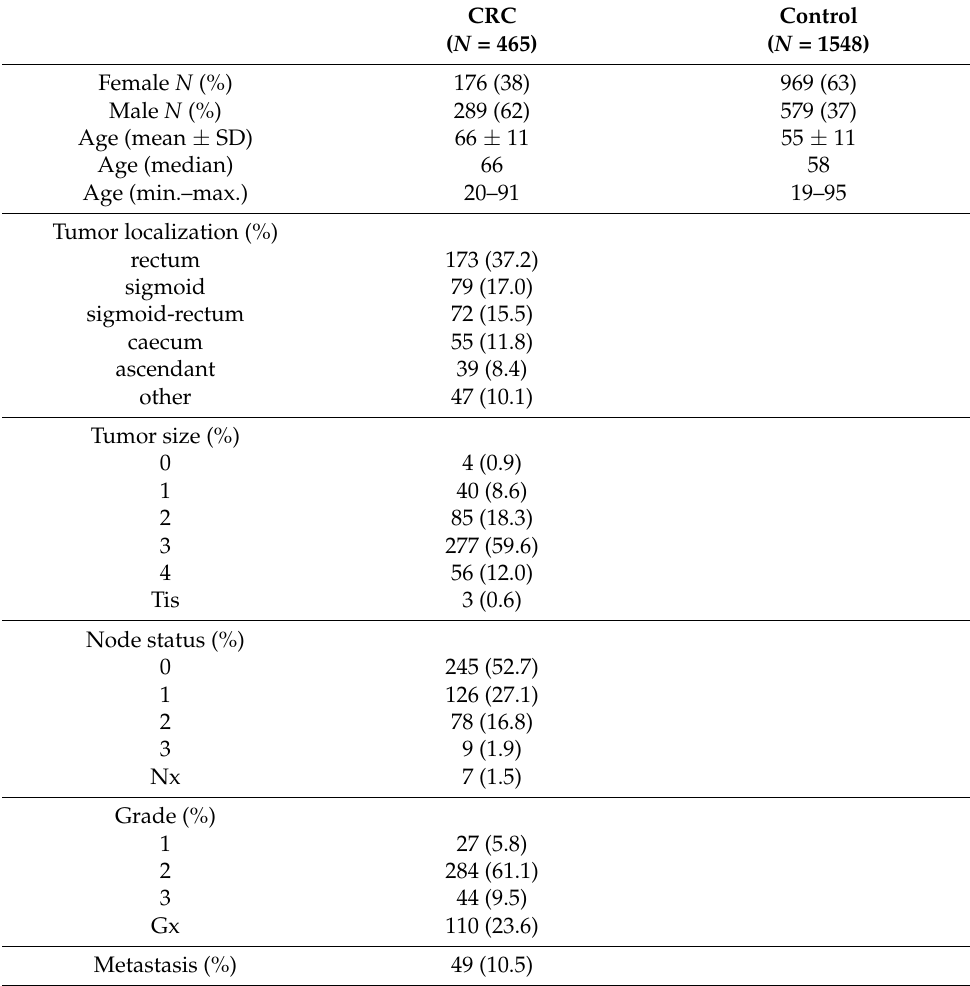
Table 1. The demographic and clinical characteristics of patients and